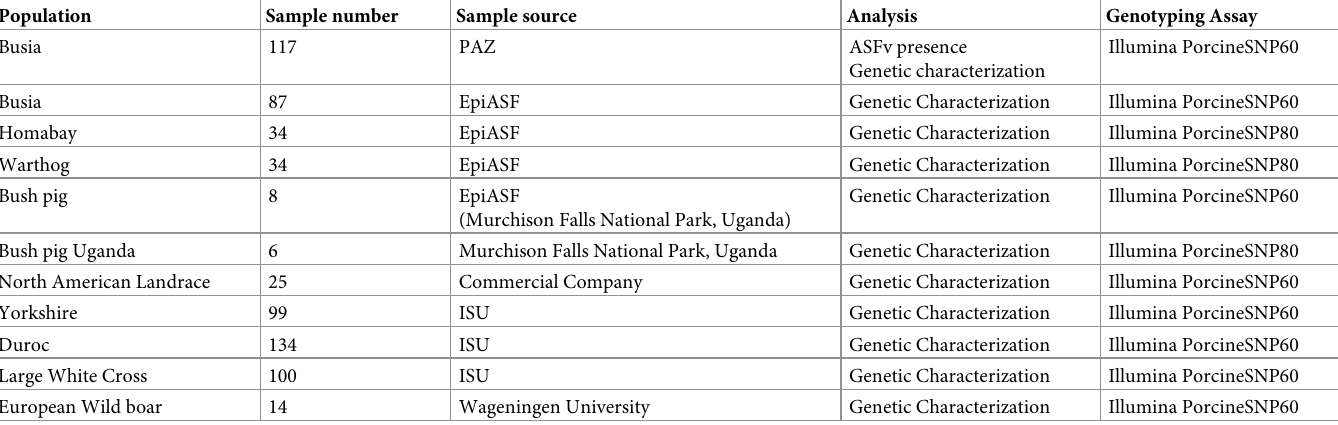
Table 1. Sample populations, source project and sample utility in the project.